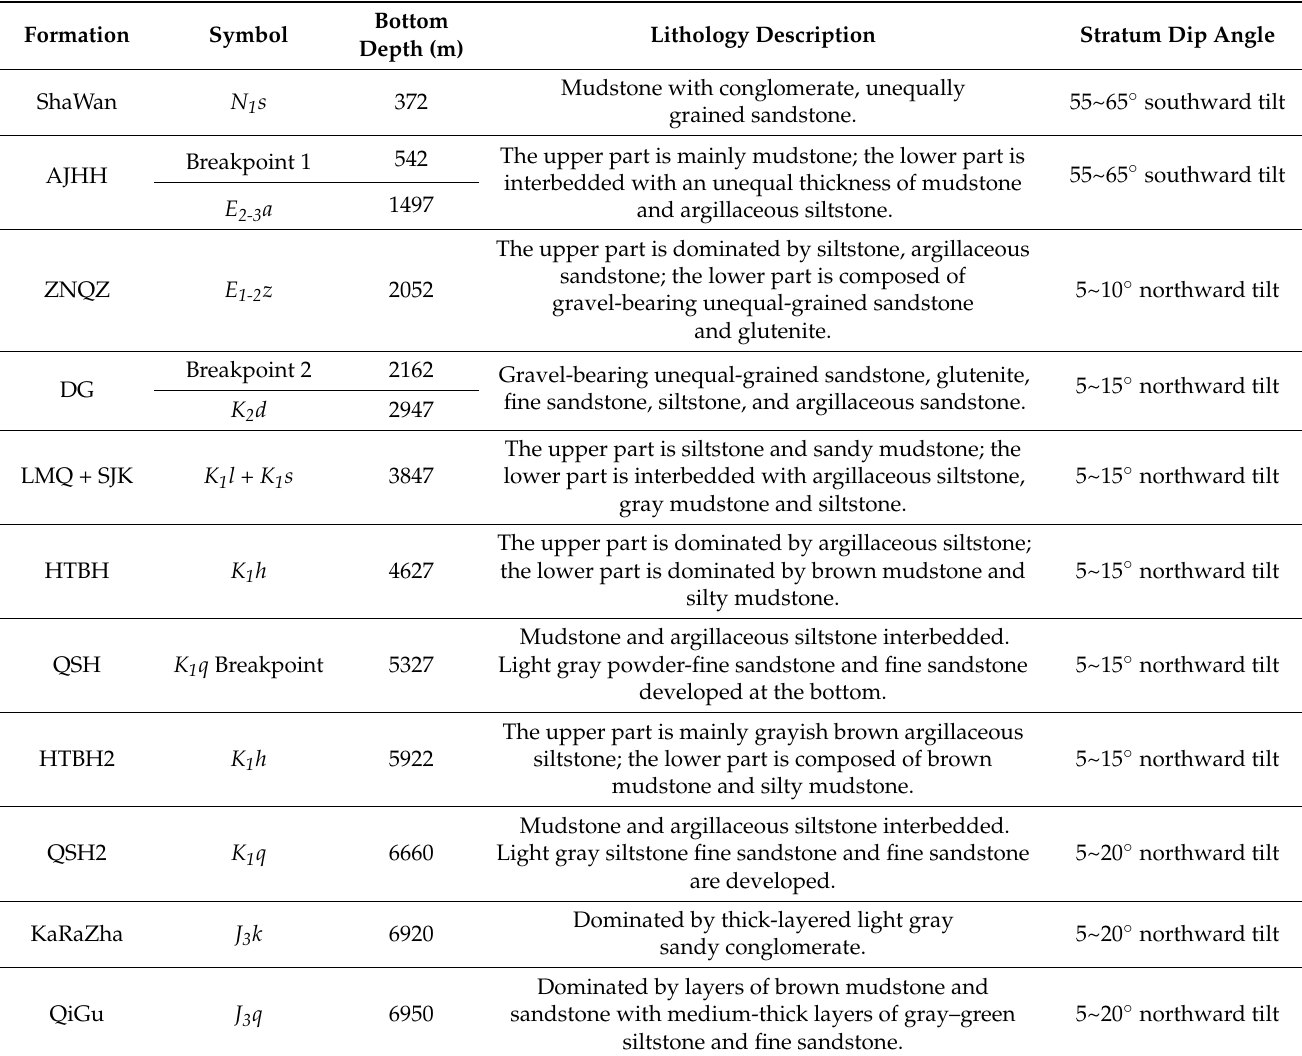
Table 1. Geological stratification and lithology description of well